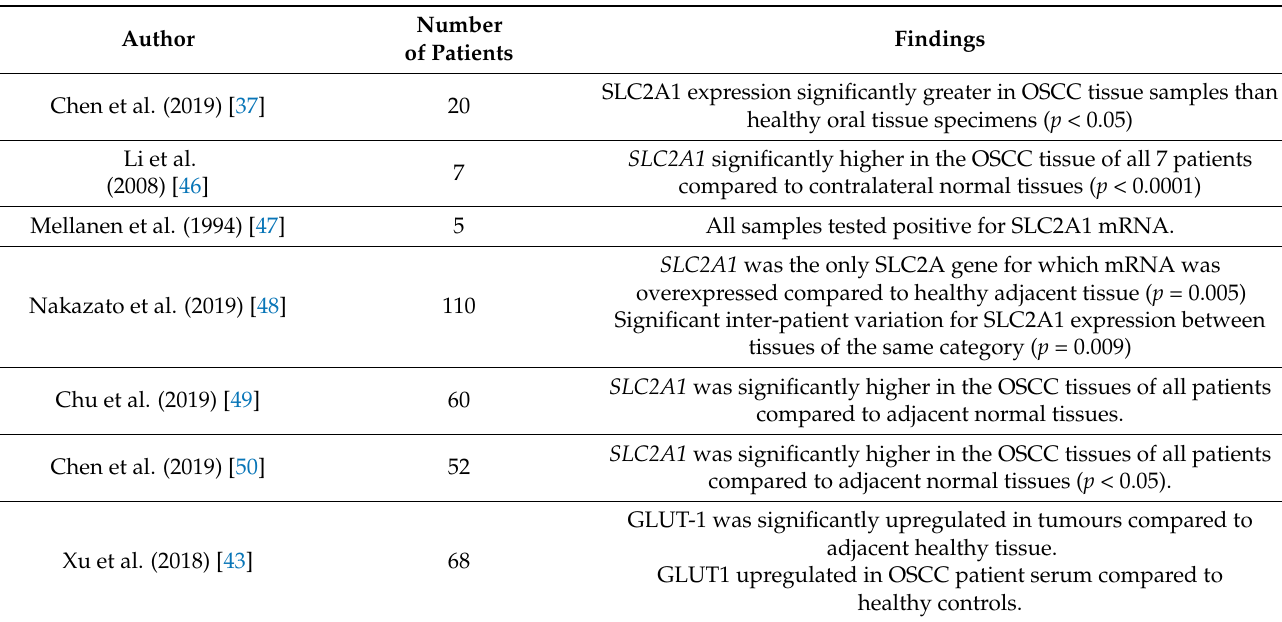
Table 2. SLC2A1 expression in